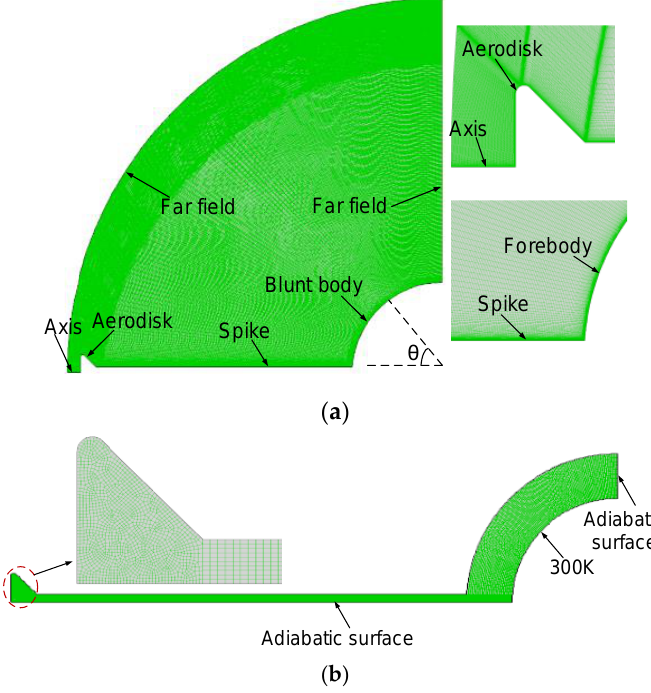
Figure 7. Computational grids of model 4: ( a ) fluid; ( b ) structure.